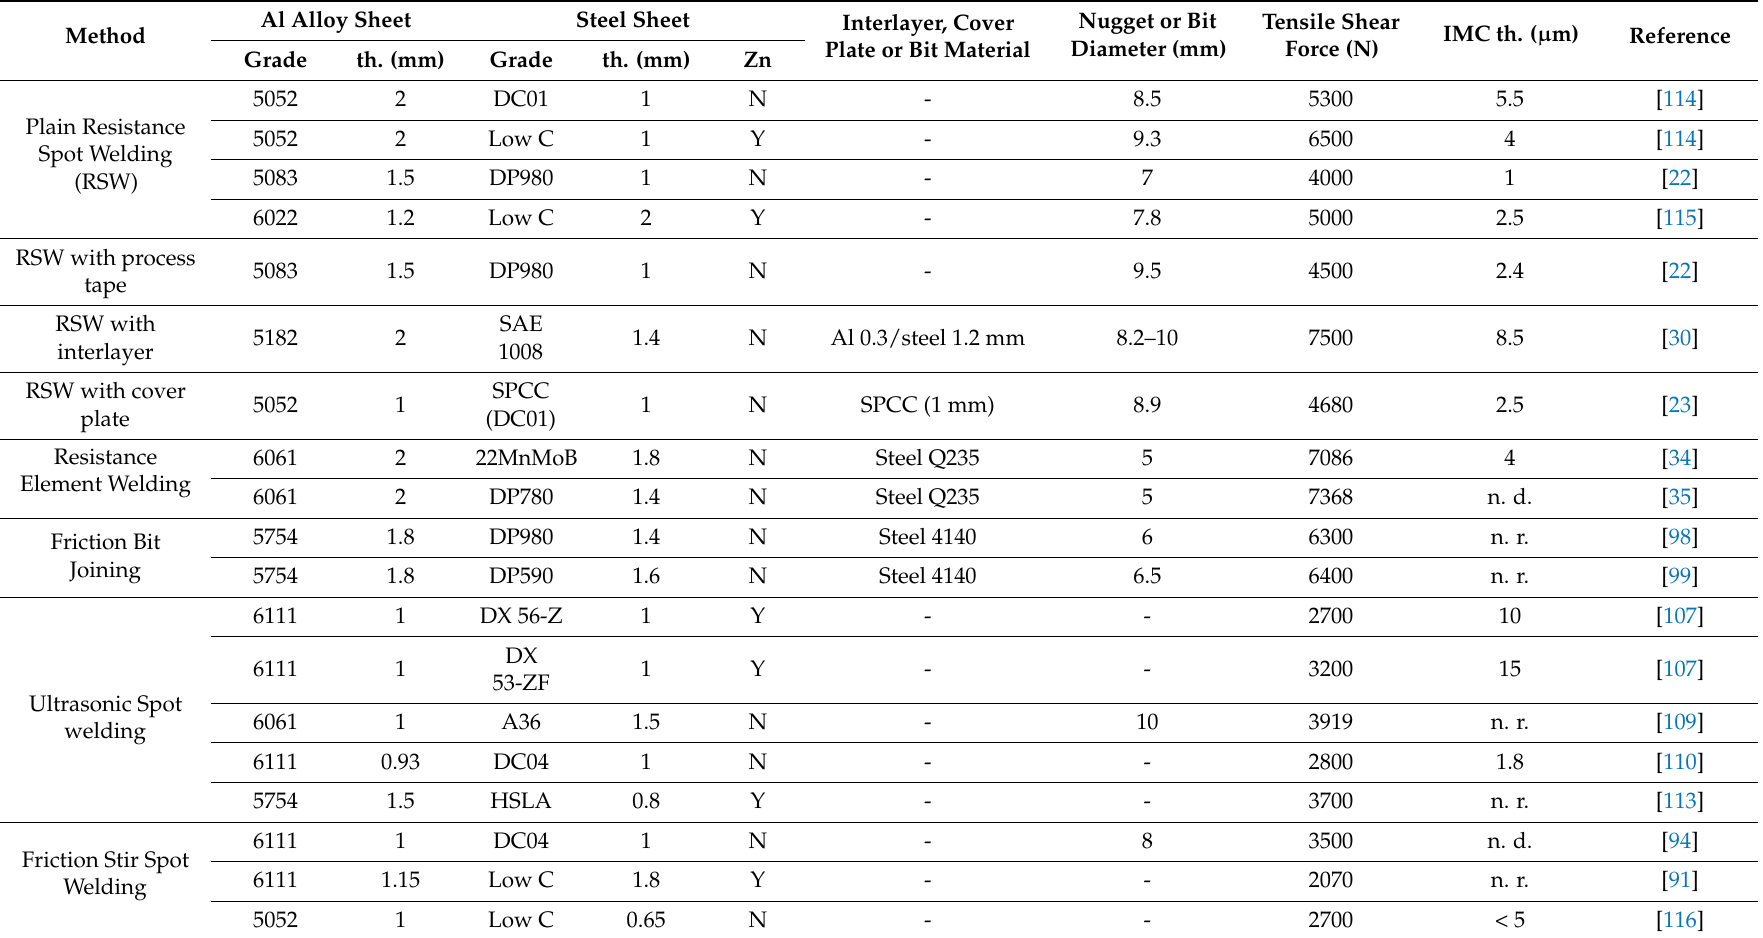
Table 1. Main results of hybrid spot joining